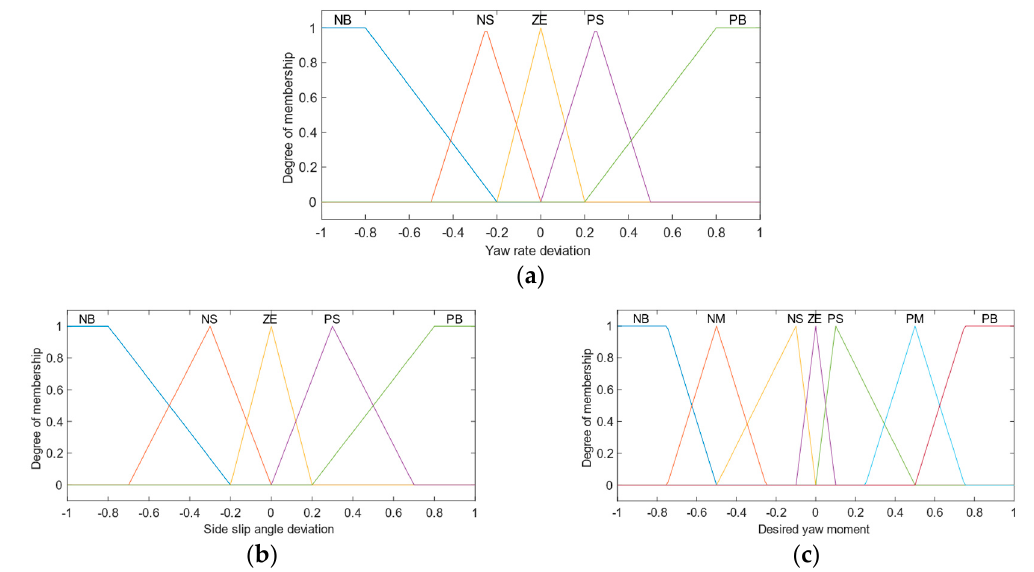
Figure 4. Membership function: ( a ) membership functions of the γ deviation; ( b ) membership functions of the β deviation; ( c ) expected yaw moment.